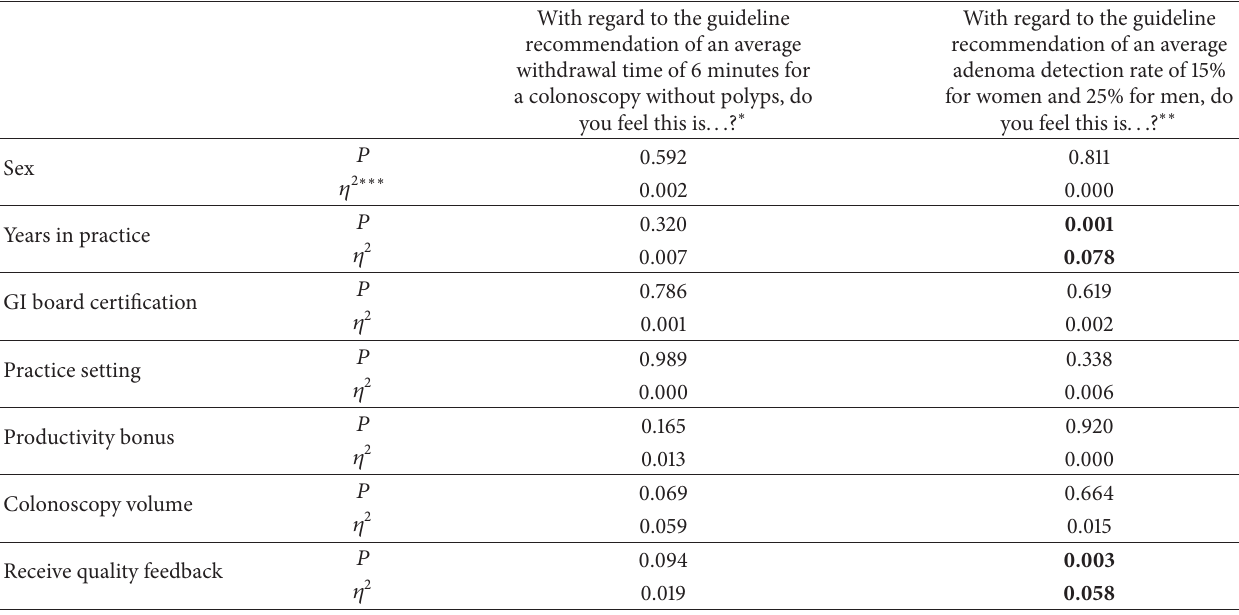
Table 5: Physician perceptions about colonoscopy quality